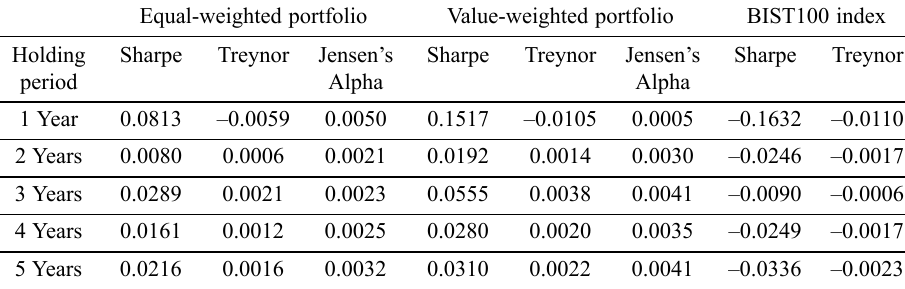
Fig. 1. Long run performance of the brand Table 6. Long run risk-adjusted performance of all sample and benchmark portfolio